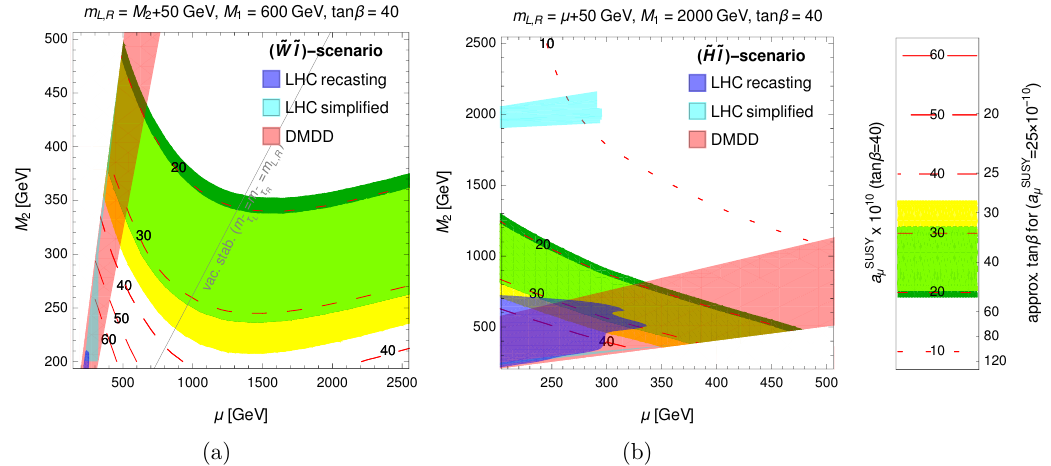
˜ ˜ ˜ ˜ Figure 17. (a) ( W l ) -scenario. (b) ( H l ) -scenario. For parameter values see the plots and the text. The red dashed contours correspond to values of a SUSY as indicated in the legend on the right; the µ yellow/green coloured regions correspond to the 1 σ bands corresponding to the BNL deviation (1.6) and the new deviation including FNAL (1.7), and their overlap. For the tan β -reinterpretation see caption of figure 15. The red shaded region is excluded by dark matter direct detection if the LSP is assumed stable; the blue shaded regions correspond to the limits from the LHC recasting, see figure 20 for details. The cyan shaded region corresponds to the additional LHC limits implemented in a simplified way; in both plots the slepton search (6.11), ref. [490] excludes a narrow strip at small µ and M , where the slepton-LSP mass splitting is largest. In the right plot the compressed- 2 mass searches of ref. [528] exclude another small region at large M , which enters the LSP mass 2 via mixing. The thin solid gray line corresponds to the vacuum stability constraint of ref. [176]; it applies in case the left- and right-handed stau-masses are set equal to the smuon/selectron masses and excludes the points to its right, i.e. with larger µ